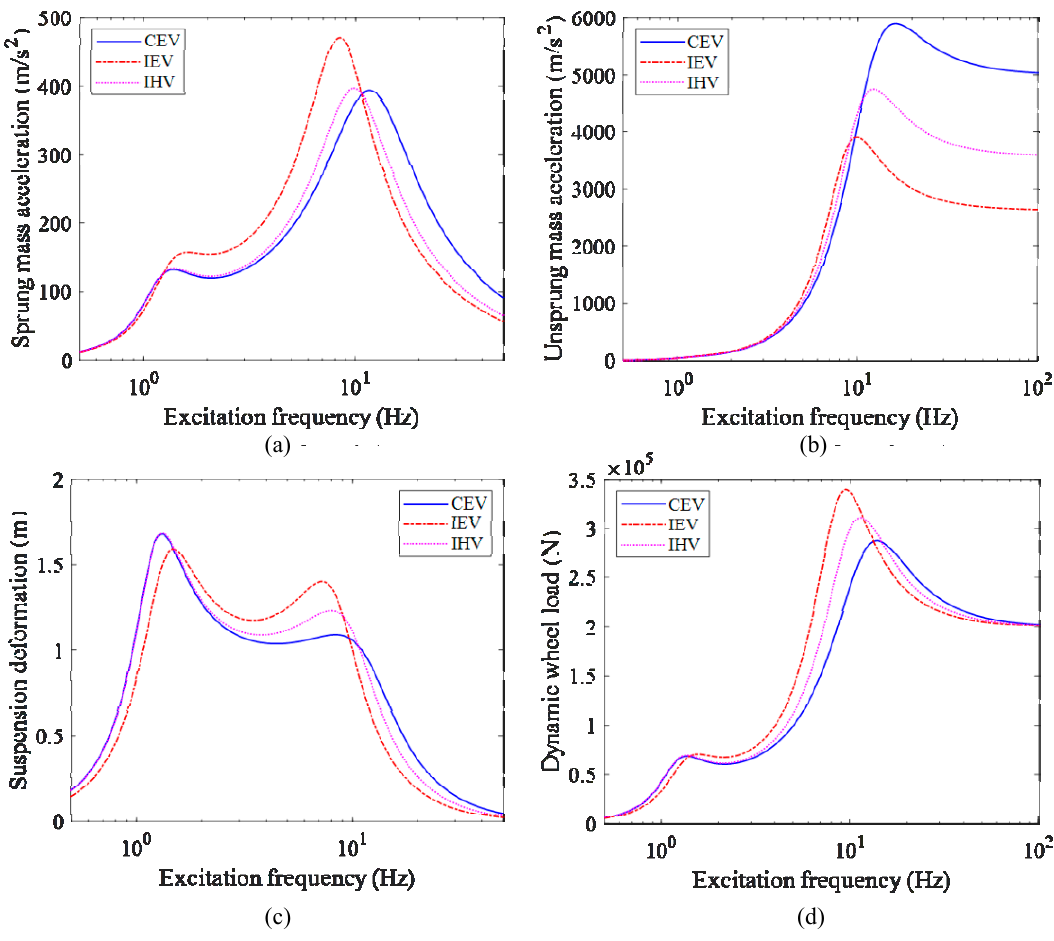
Figure 12. Frequency response of vehicle-to-road excitation.